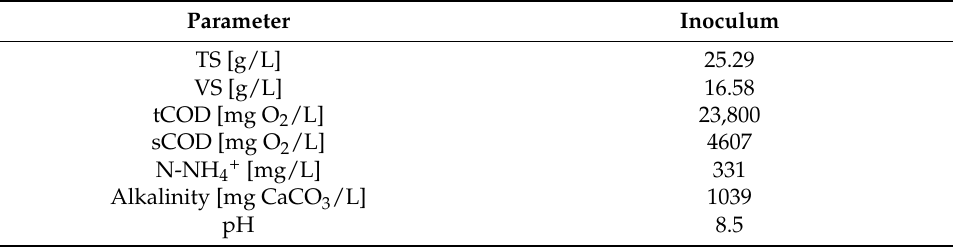
Table 1. Characteristics of the thermally pretreated digested sewage sludge used as an inoculum in the dark fermentation tests.